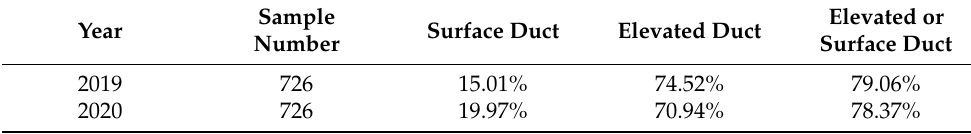
Table 2. Occurrence probability of surface ducts and elevated ducts.